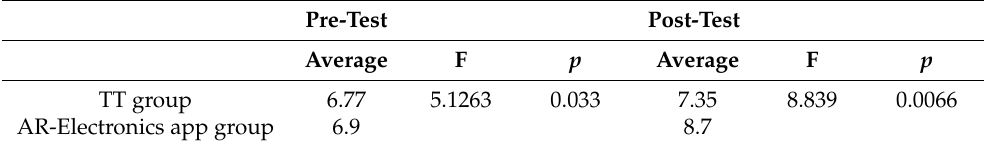
Table 6. Participating